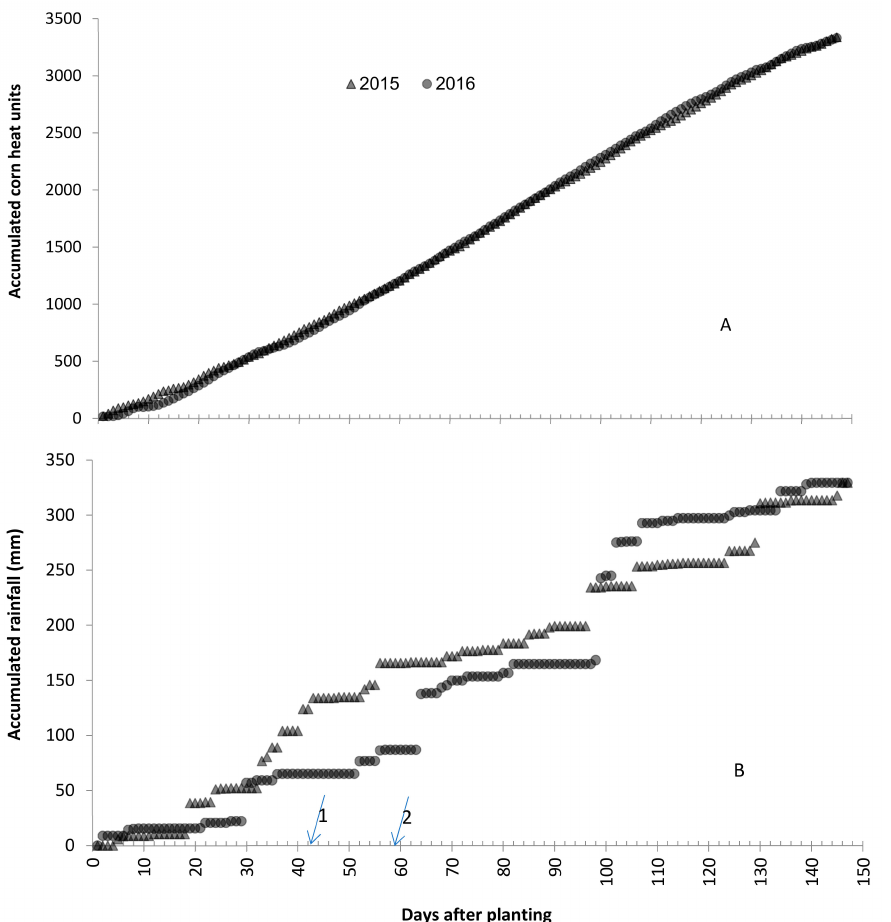
Figure 1. ( A ): Accumulated corn heat units (ACHU), and ( B ): accumulated rainfall (mm), from planting date (May 7th) to 30 September 2015 and 2016. Arrow 1 and arrow 2 indicate the 1st and 2nd inoculation dates. The first inoculation date was June 16th in both years; the second inoculation date was 2 July 2015 and 4 July